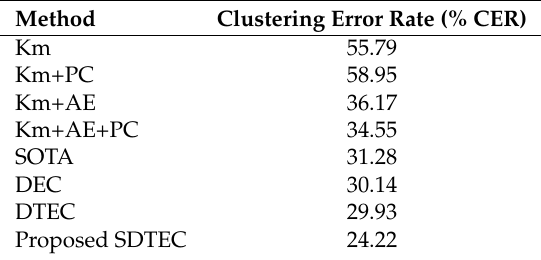
Table 2. The clustering performance comparison.